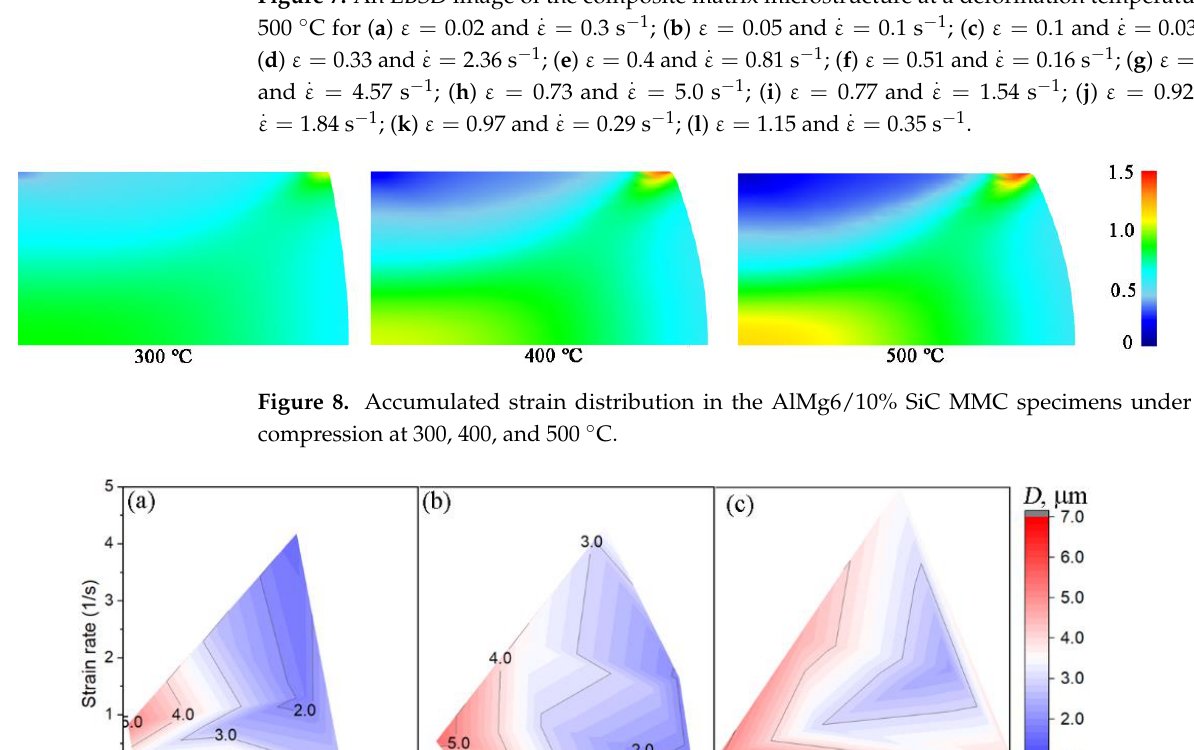
Figure 10. The effect of strain and strain rate on the fraction of low-angle boundaries depending on temperature, °C: ( a ) 300, ( b ) 400, ( c ) 500. The dependences are plotted from the results of the EBSD analysis of the microstructure.